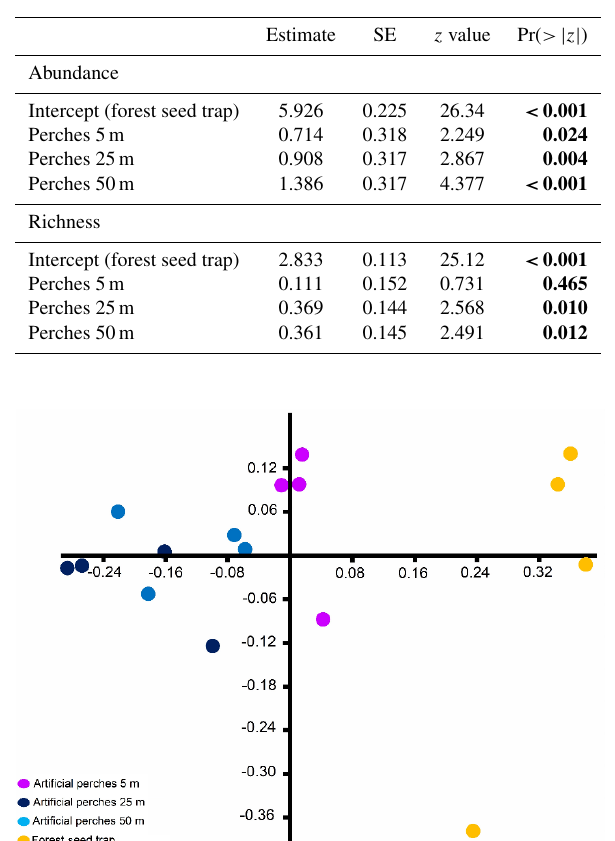
Table 2. GLMM output from effects of forest seed traps and dis- tances of artificial perches (5, 25, and 50m) on abundance and rich- ness of seeds sampled at the Cascata Experimental Station, southern Brazil. SE: standard error. The values are on the log-link scale. Val- ues in bold are significant.